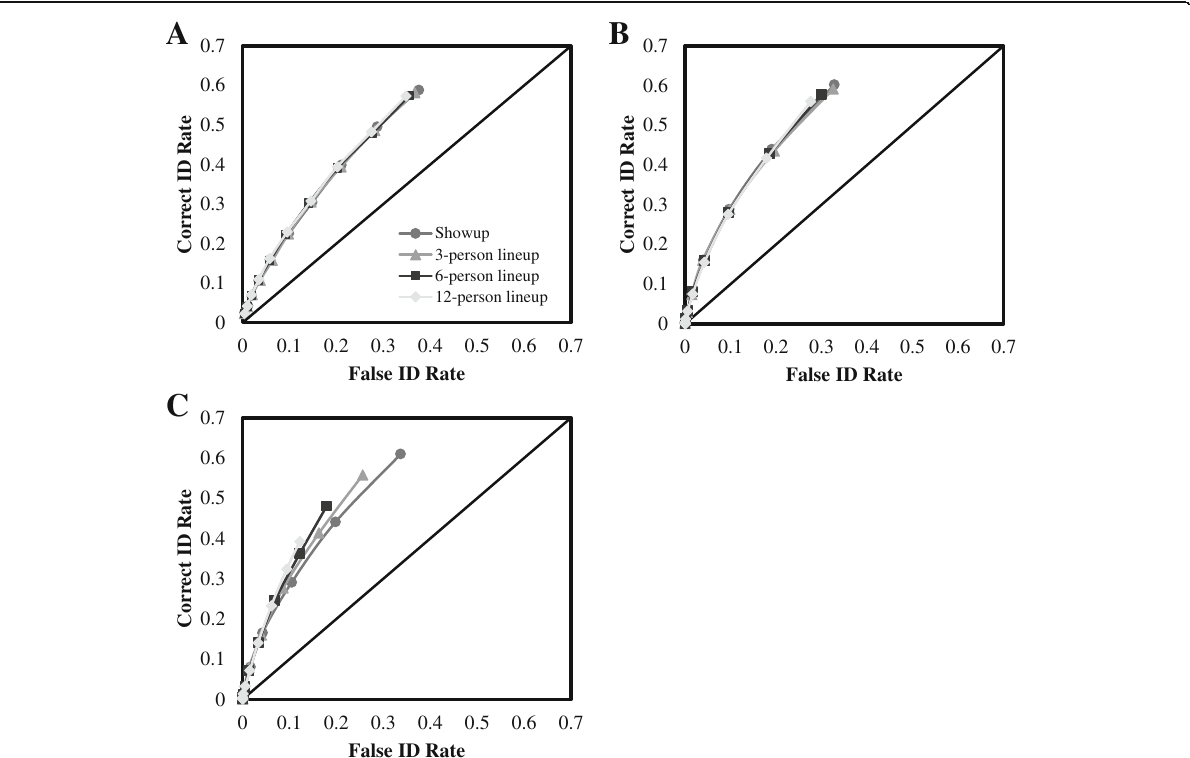
Fig. 2 Receiver operating characteristic (ROC) curves comparing showups, 3-, 6-, and 12-person biased lineups SSP =.75, making the innocent suspect a better match to the PERP than the fillers. a SSF =0.0, b SSF =.3, c SSF =.6. Encoding constant at a =.3, and csim = csu =.09. The solid diagonal line indicates chance performance. SSP Similarity of the innocent Suspect to the PERP, SSF Similarity of the Suspect to the Fillers, PERP